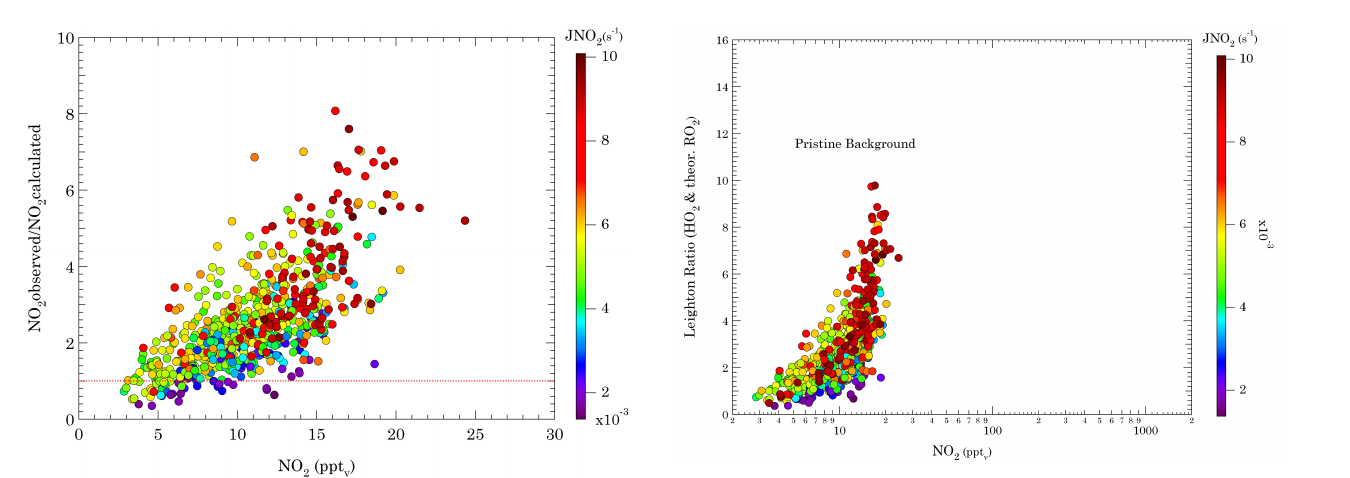
Fig. 5. The ratio of the observed and the PSS-calculated NO 2 con- centrations as a function of NO 2 in the unpolluted MBL. The color coding indicates the NO 2 photodissociation frequency.